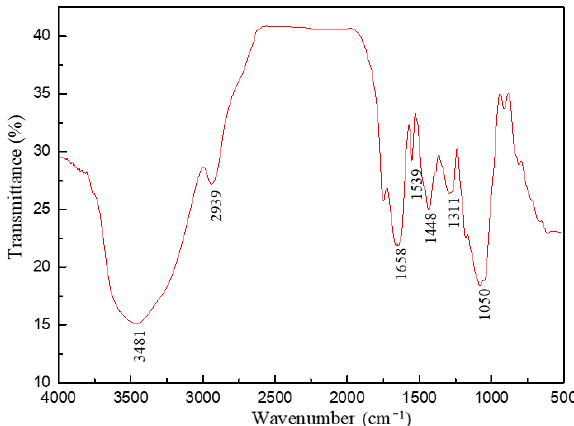
Figure 7. The FT-IR spectra of VR-H.